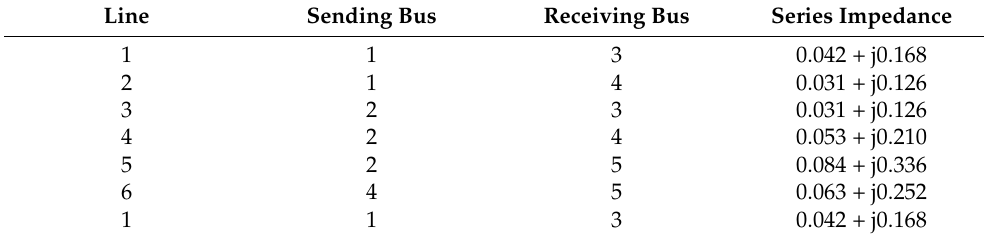
Table 3. Test system line data (in pu).